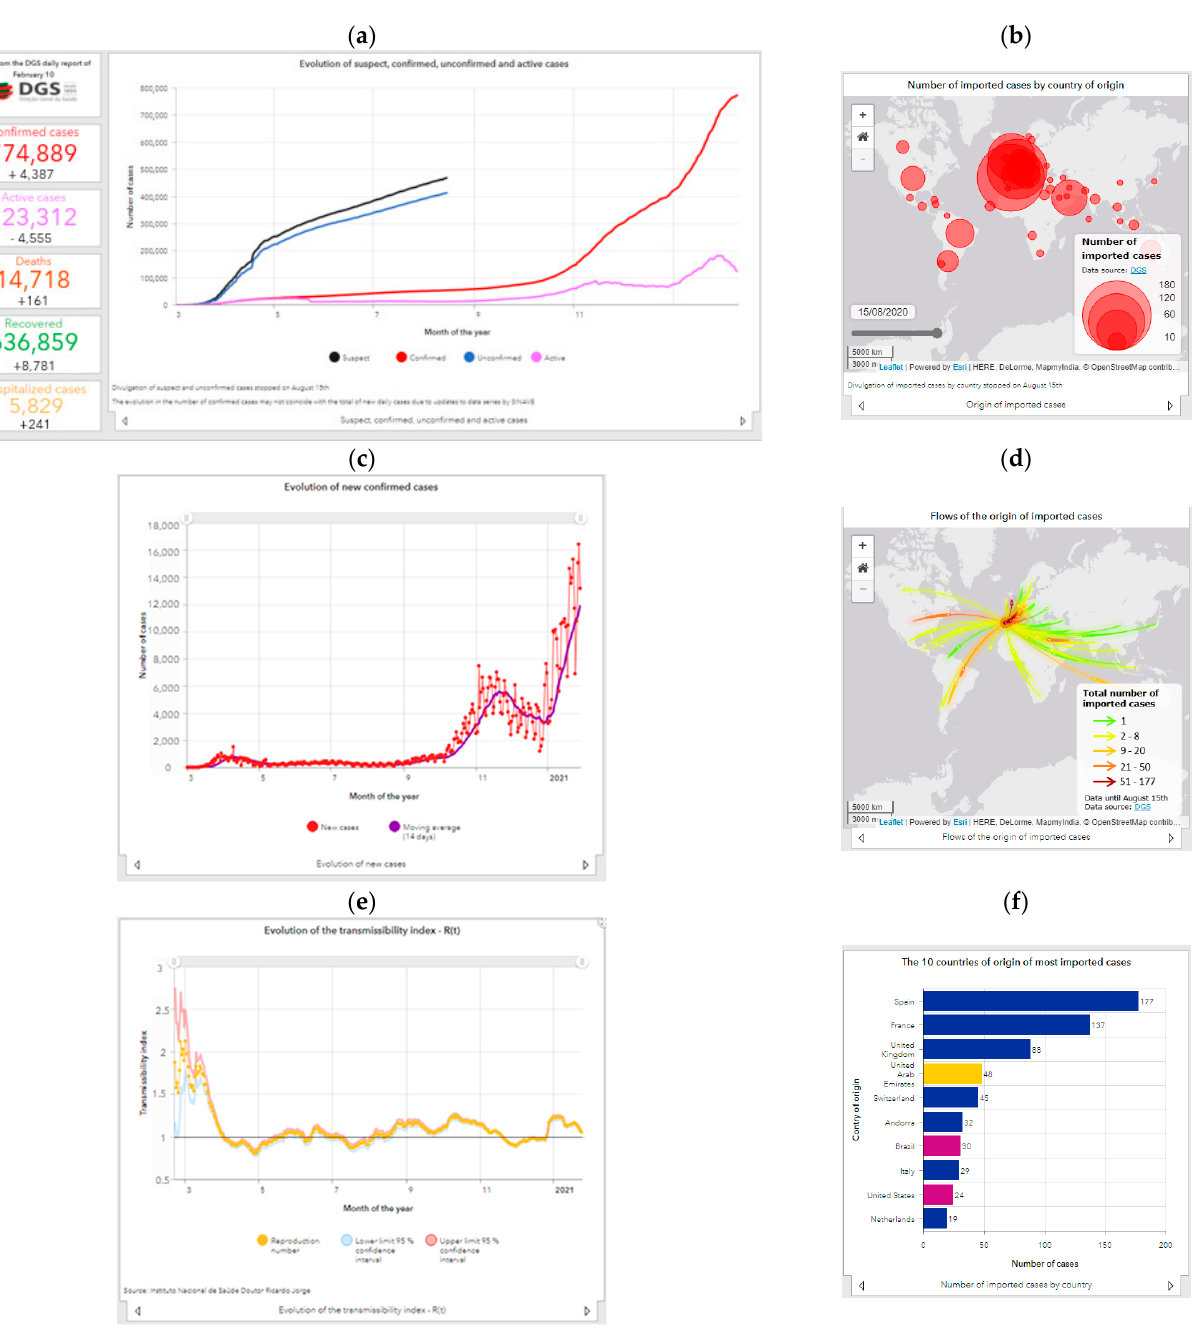
Figure 6 - Example of dashboard elements for the national scale. Source: https://www.comprime-compri-mov.com (accessed on 9 February 2021).